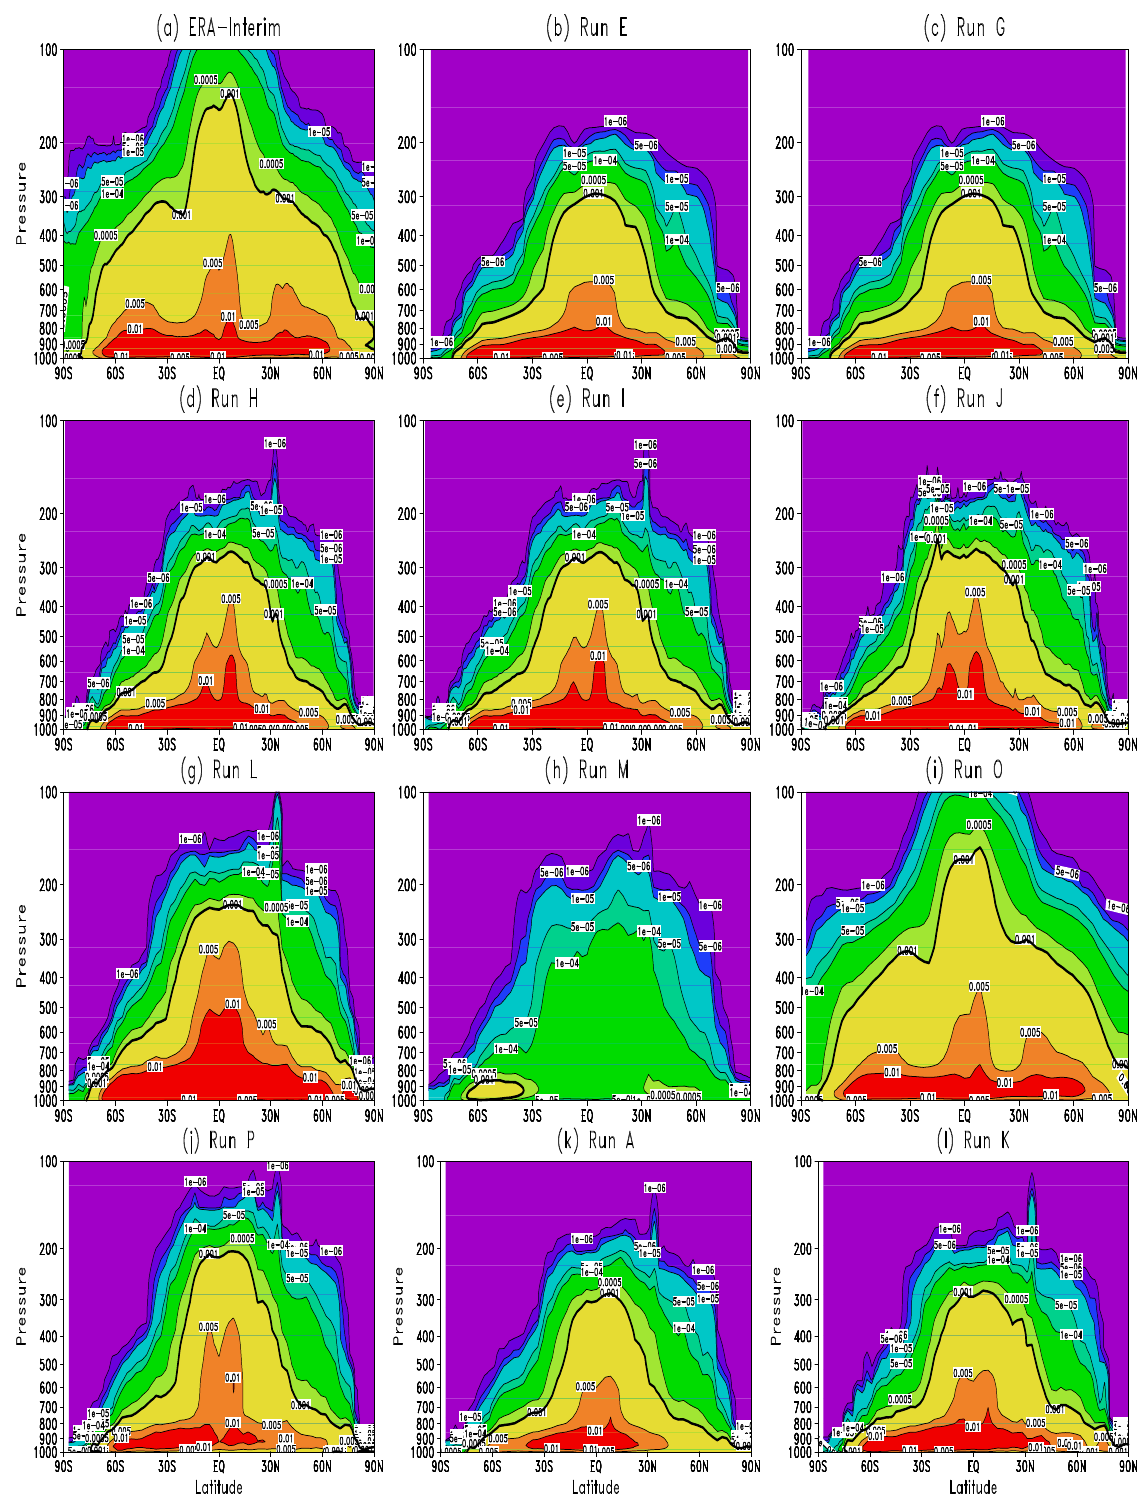
Fig. 6. Zonal mean annual mean convective updraft mass flux (kgm − 2 s − 1 ) for 2005 for (a) ERA-Interim reanalyses (1 ◦ × 1 ◦ grid), (b) run “E EInewevap”, (c) run “G 5.6”, (d) run “H 1.1”, (e) run “I 1.4”, (f) run “J T106”, (g) run “L 2EVAP”, (h) run “M 0EVAP”, (i) run “O EIar”, (j) run “P det”, (k) run “A E40”, and (l) run “K L31”. The bold contour indicates 0.001kgm − 2 s − 1 .